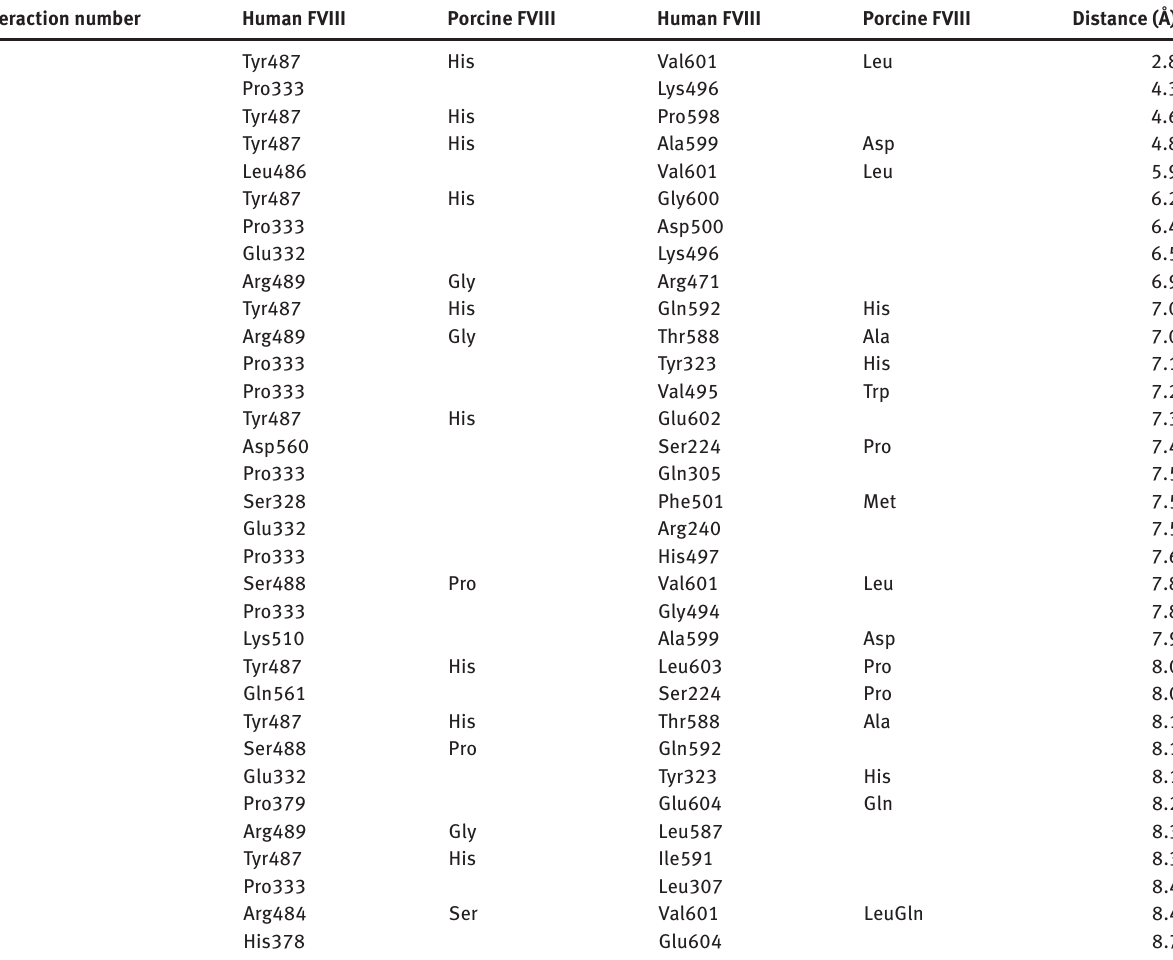
Table 1: Amino acid residues at the FVIII monomer-monomer interface in a radius < 8.7 Å. Interaction